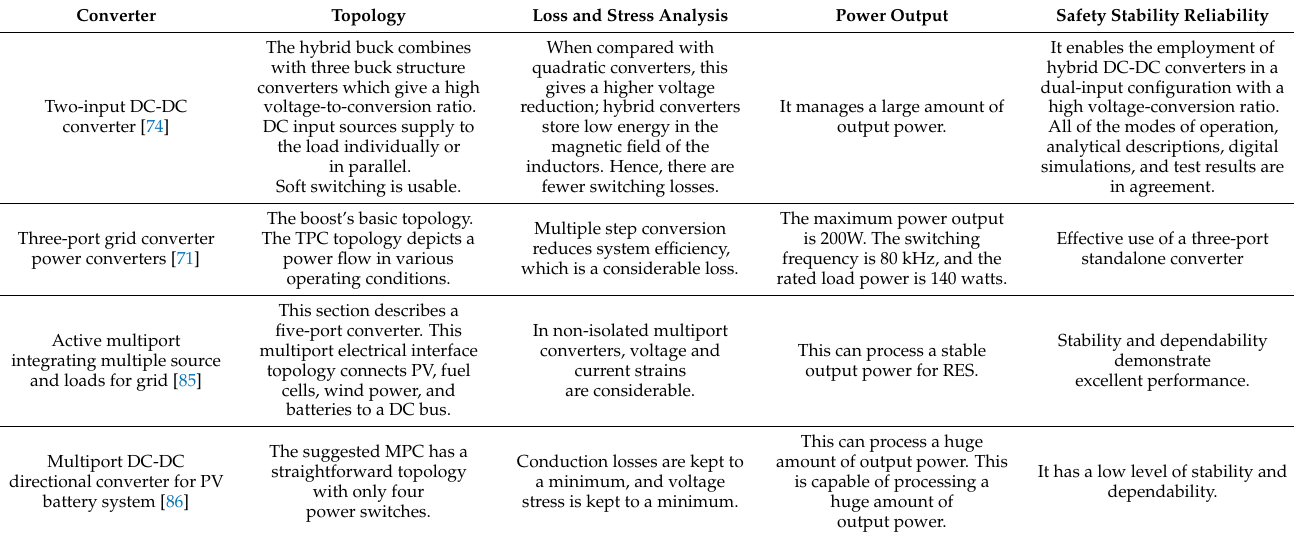
Table 5. Different types of renewable energy multiport